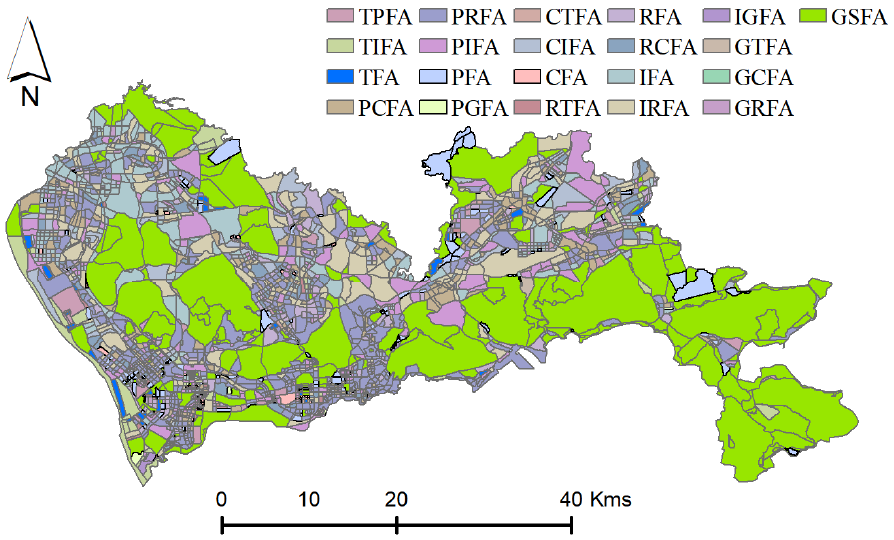
Figure 3. The identification results of urban functional area (the geographical background is obtained by overlaying roads and administration boundary of Shenzhen city).